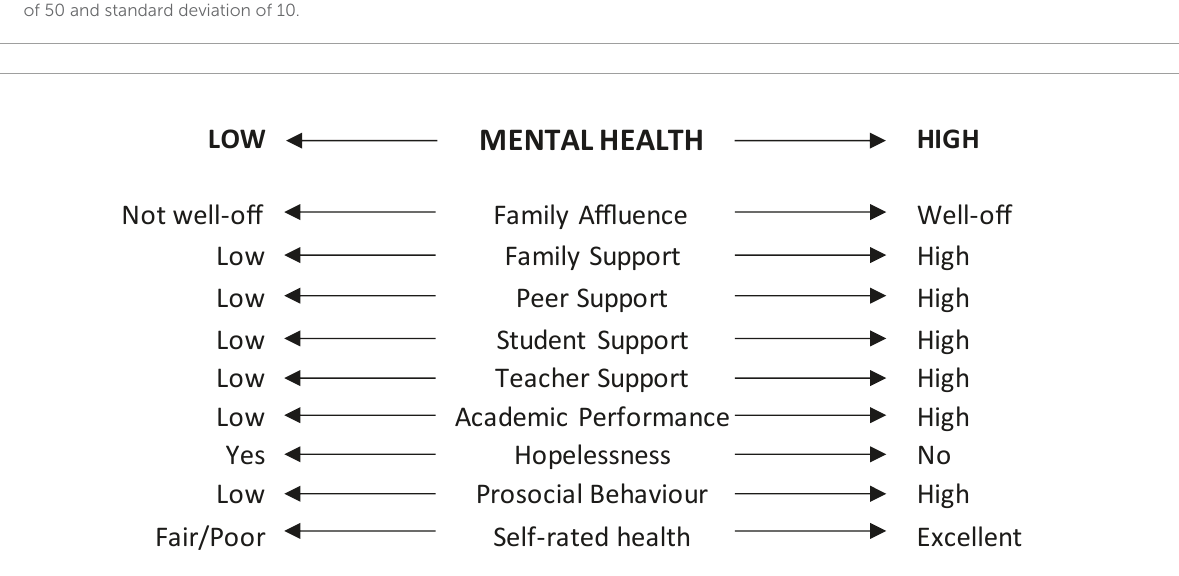
deviation of 10. A SWB score was calculated by summing standardized life satisfaction and positive affect scores, and